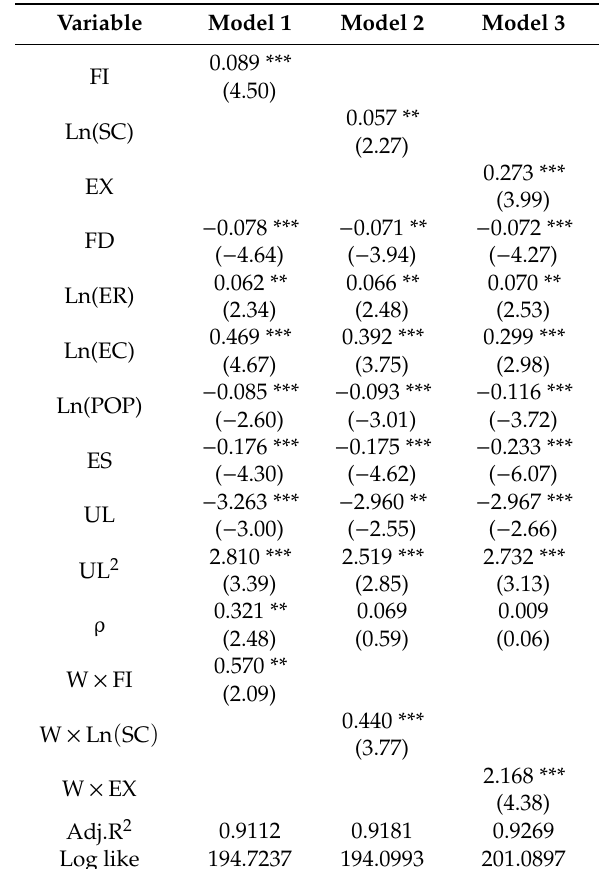
Table 4. The results of the spatial model at the provincial